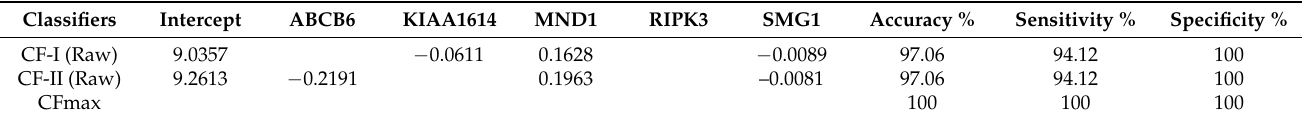
Table 6. Performance of individual classifiers and combined max-competing